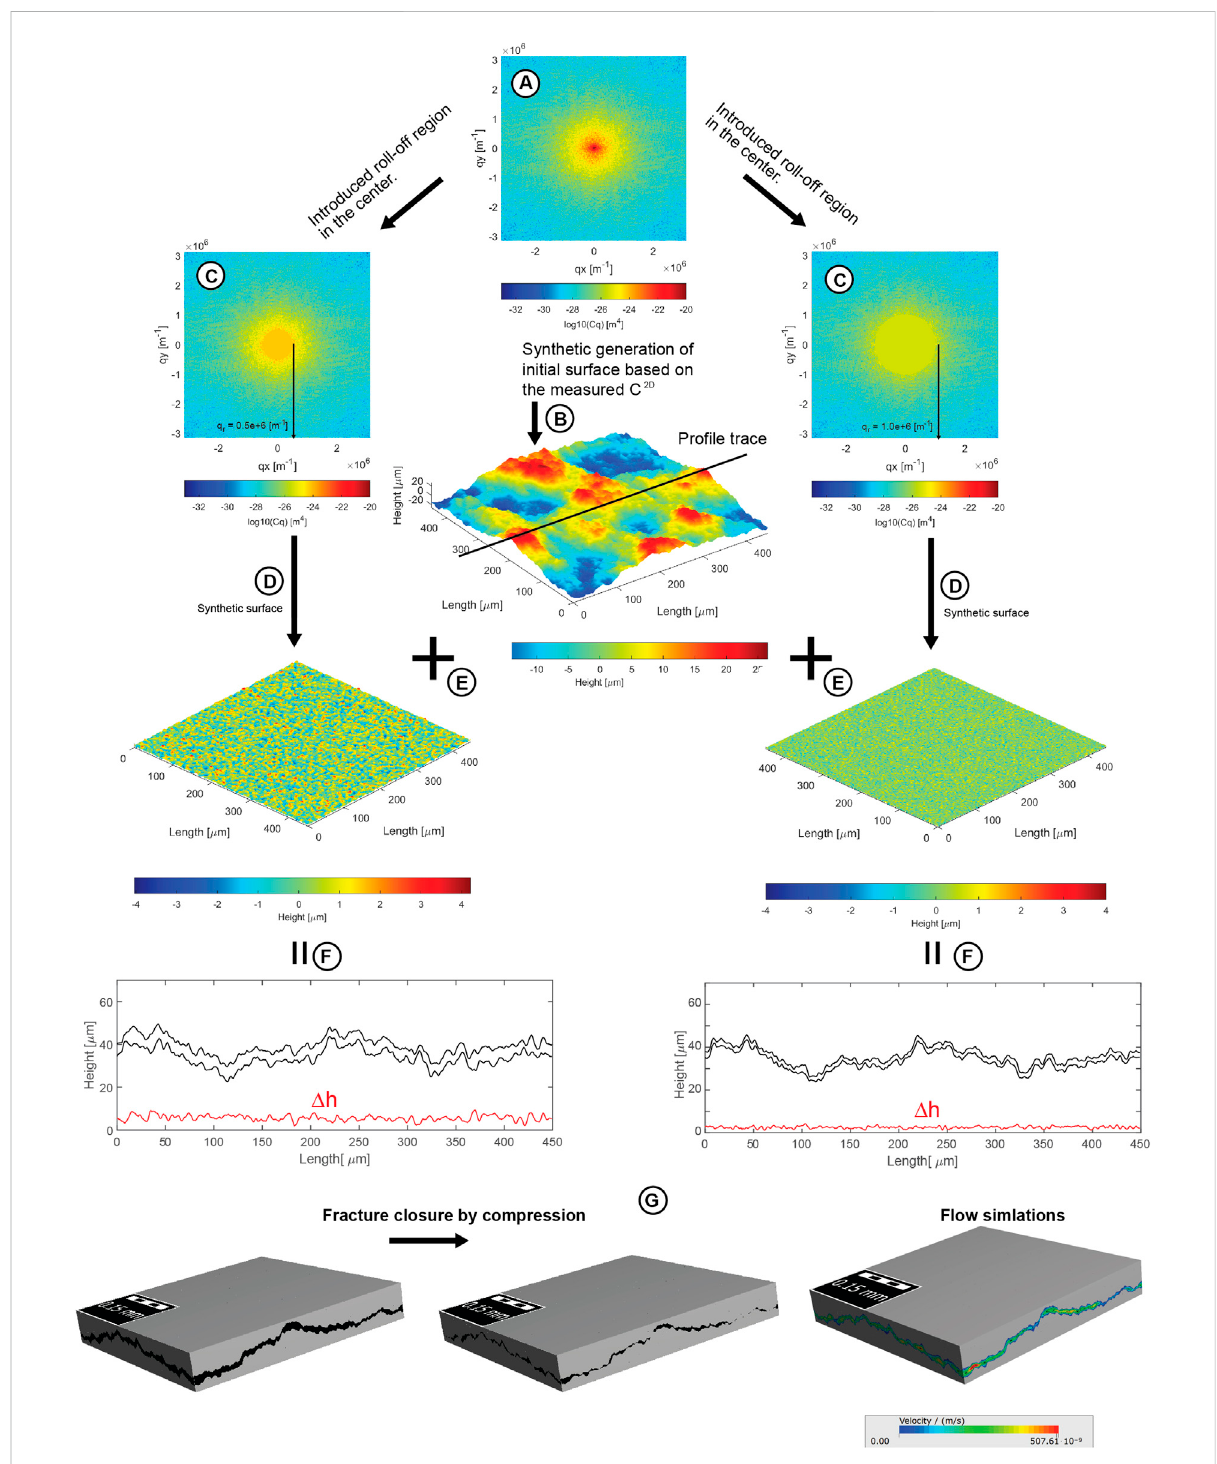
FIGURE 5 Procedureofarti fi cialfracturegenerationbytakingtheslickensidesfracturetypeasexample.Theinitialsurfacesweregenerated (B) usingthemeasuredC 2D (A) (seealso Figures3,4).Forallfracturemodels,thelowerandupperfracturesurfacesconsistoftheseinitialsurfaces.Theshortwavelengthroughnesselementsintheinitialsurfaces (A) were modi fi edsothatthemis fi tbetweenthetwofracturesurfacesisde fi nedbydifferentshortwavelengthroughnesselementsinthelowerandupperfracturesurfaces.Thereby,the initialfracturesurfacewascombined (E) withrandomsurfaces (D) whichweregeneratedfromthemeasuredbutmodi fi edC 2D (C) ,wherearoll-offregionwasintroduced. Thecongruencebetweenthetwofracturesurfacesiscontrolledbydifferentvaluesofroll-offwavevectorsq r (C,D) .Aftergeneratingthelowerandupperfracturesurfaces,these were brought into contact. (F) Shows pro fi les through the resulting fractures along with the related aperture Δ h which documents the in fl uence of the procedure on the congruence. (G) In order to simulate fracture closure mechanism and transport, the fracture models were